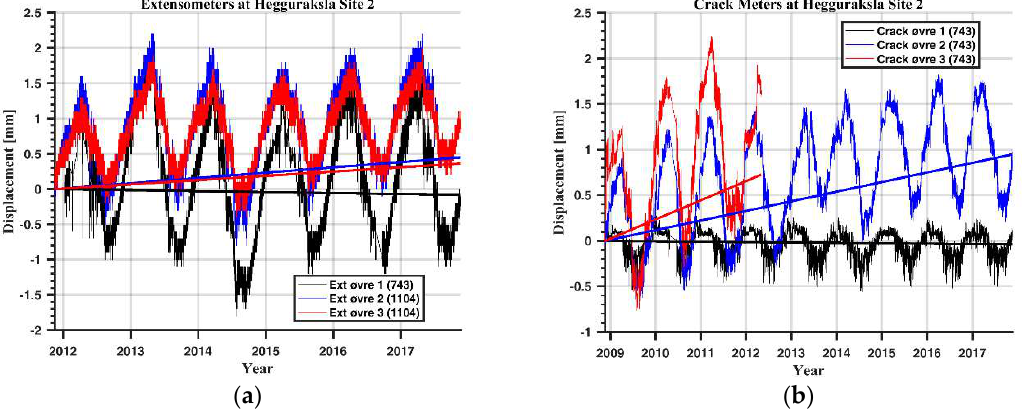
Figure 20. Displacement as a function of time from the extensometers and crack meters at Site 2. ( a ) The extensometers show a displacement varying from −0.08 mm to 0.45 mm. ( b ) The crack meters show a displacement varying from −0.04 mm to 0.95 mm.